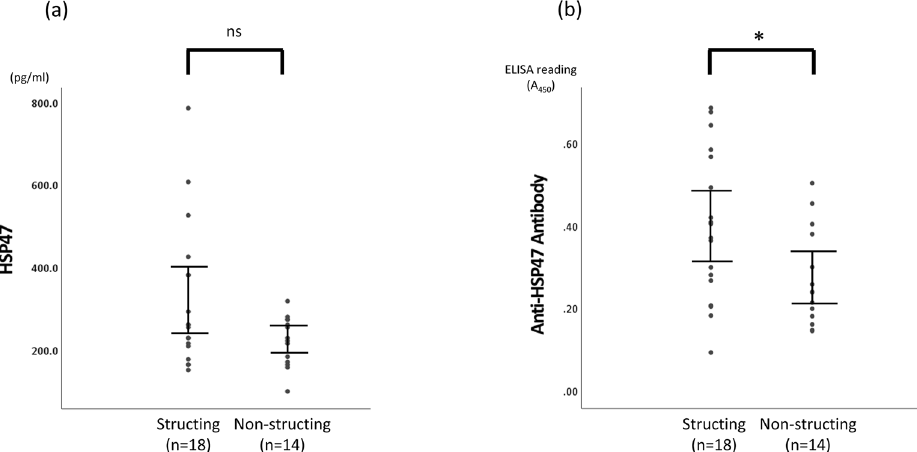
Figure 3. Comparison of serum HSP47 and anti-HSP47 antibody levels between stricturing and nonstricturing disease in patients with CD. Quantitative analysis of ( a ) HSP47 and ( b ) anti-HSP47 antibody levels in stricturing and nonstricturing groups in patients with CD. ( b ) Quantitative analysis of anti-HSP47 antibody in CD patients with and without intestinal stricturing. Each dot represents one subject, and bars indicate average ± SEM.